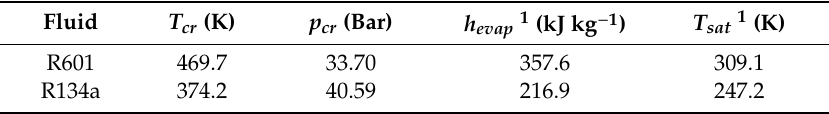
Table 3. Properties of the working fluids.